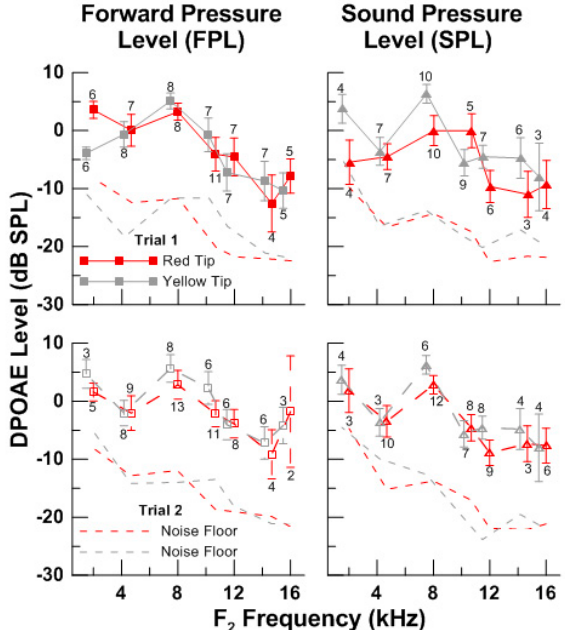
Figure 4. Average DPOAE levels in newborns across frequency using either a red (red symbols) or yellow (gray symbols) eartip and FPL ( left panel ) or SPL ( right panel ) for calibration. Solid lines in the top panels represent trial 1 and long-dashed lines in the bottom panels represent trial 2 data. Short-dashed lines in all panels denote the average noise floor for each condition. The number of data points for each frequency are indicated at the top or bottom of the standard error bars in each plot.